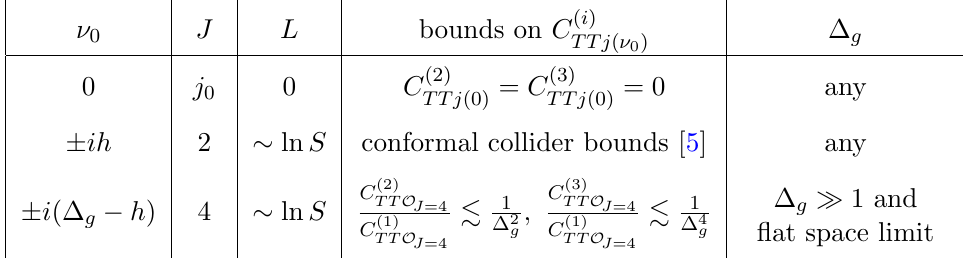
i ((cid:1) g h ), (cid:6) (cid:0)